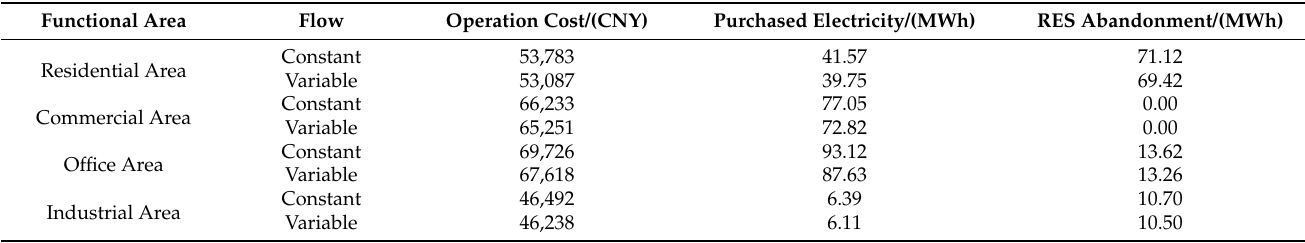
Table 3. System operation cost, purchased electricity, and RES abandonment of each functional area under indepen- dent